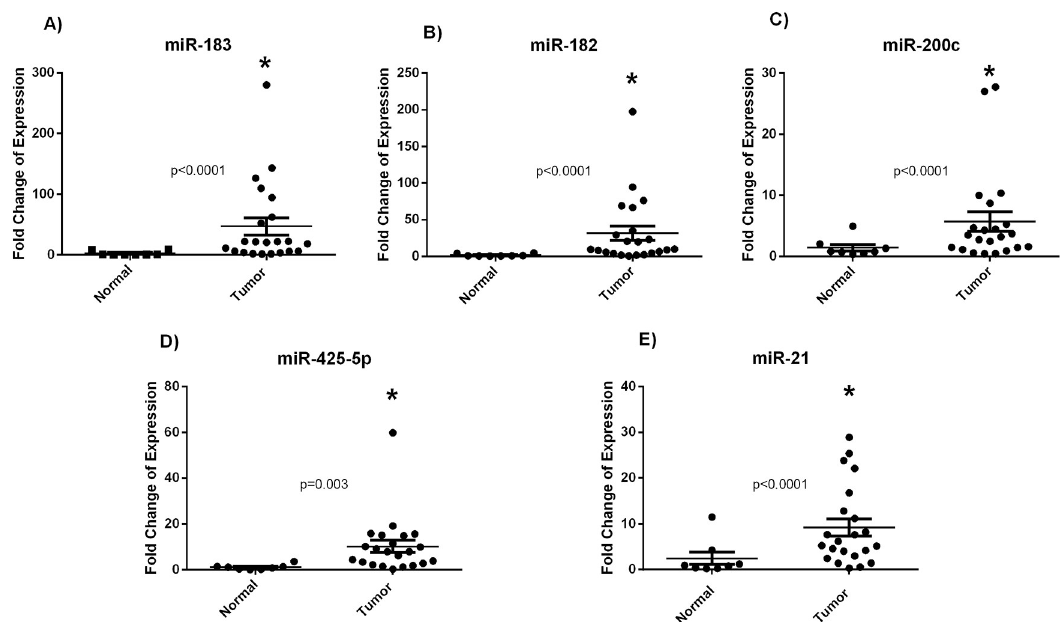
Fig 1. Upregulated miRNA expression in Algerian breast cancer tissues. Dot plots show the fold change of expression of miR-183, miR-182, miR-200c, miR-425-5p and miR-21 in tumor breast cancer tissues compared to the normal adjacent tissues, obtained using RT-qPCR with RNU6B as an endogenous control. � signifies p < 0.05, using Wilcoxon signed rank test.